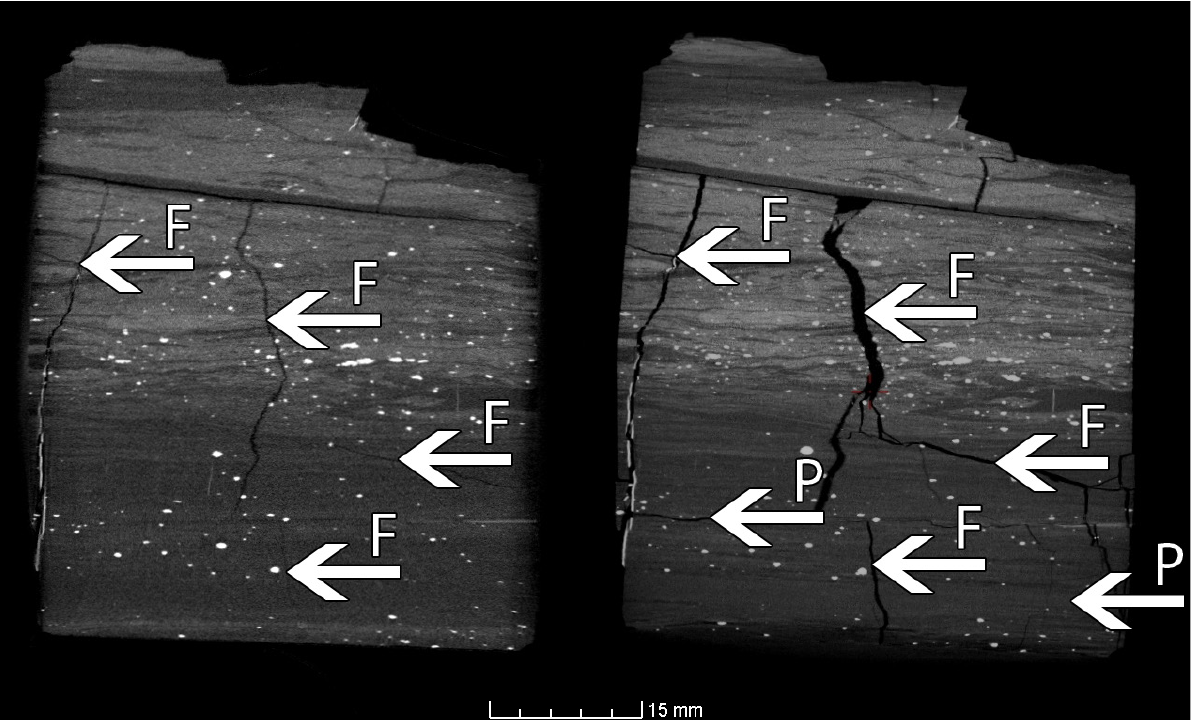
F indicates cleats or cracks that existed in the pre-loaded particles that enlarged during compression; P indicates either maceral–maceral boundaries or maceral–mineral boundaries that may have had an influence on crack initiation. Figure 6: Comparison of a particle before (left) and after (right) impaction with the bedding plane parallel to the anvil.